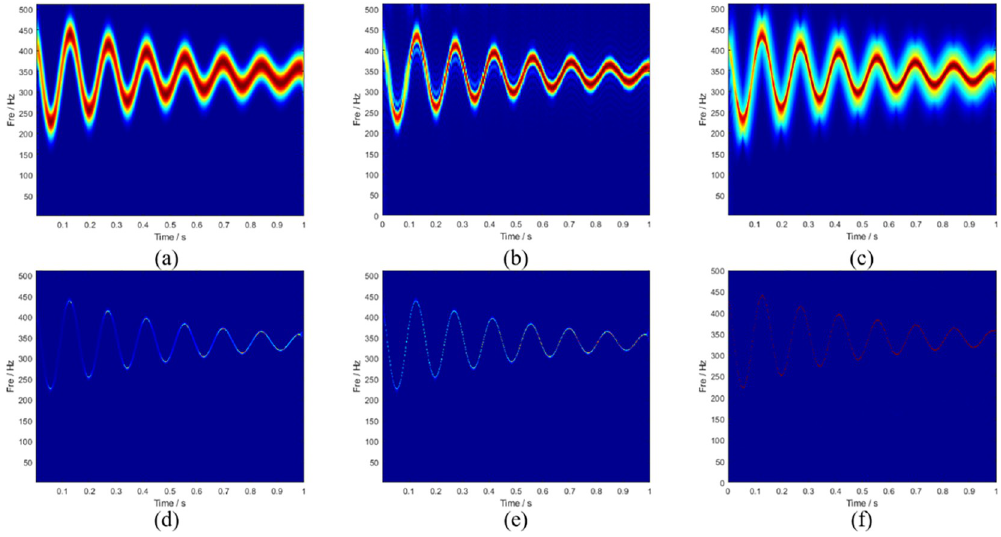
Fig 2. TFA results obtained through (a) STFT, (b) SBCT, (c) GLCT, (d) SST, (e) RM, and (f) LMSBCT.